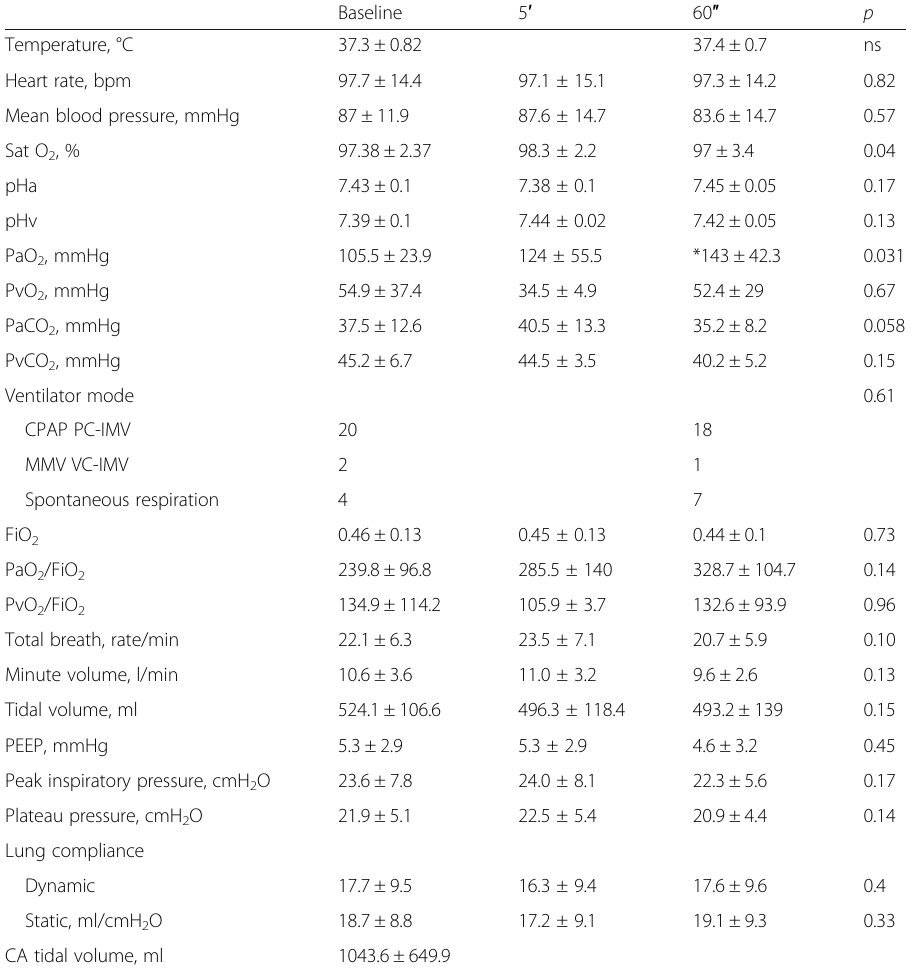
Table 2 Baseline and follow-up respiratory and hemodynamic parameters Baseline 5 ′ 60 ″ 37.3 ±